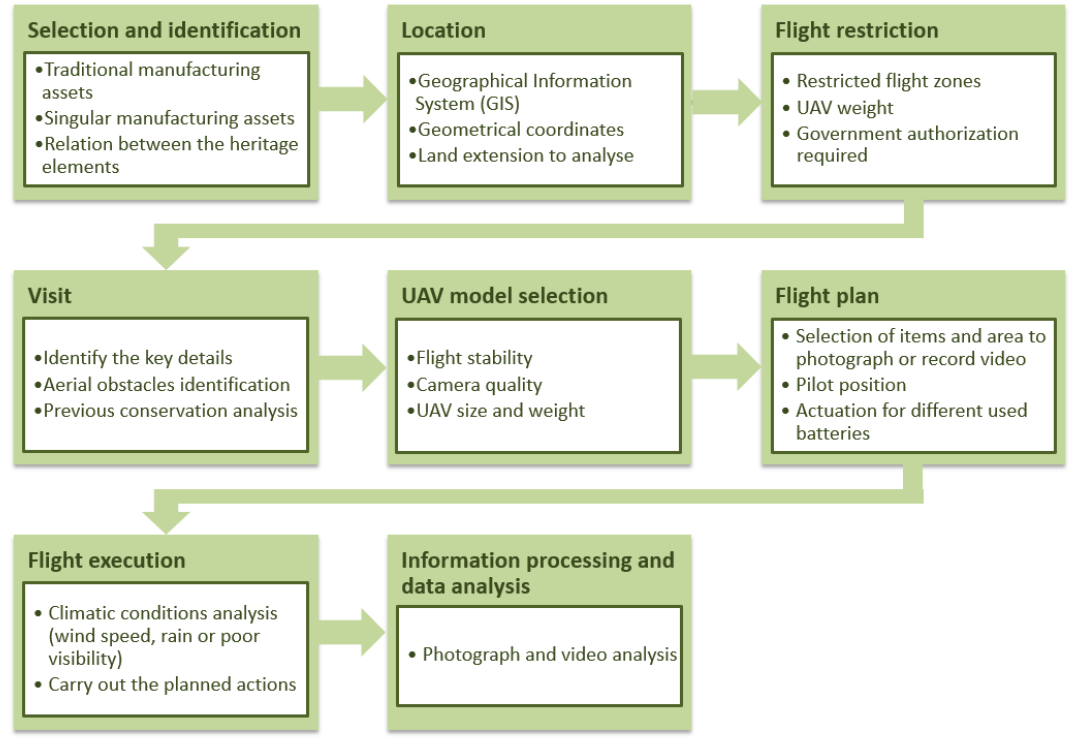
Figure 2. Methodology for the UAV use in graphic applications.